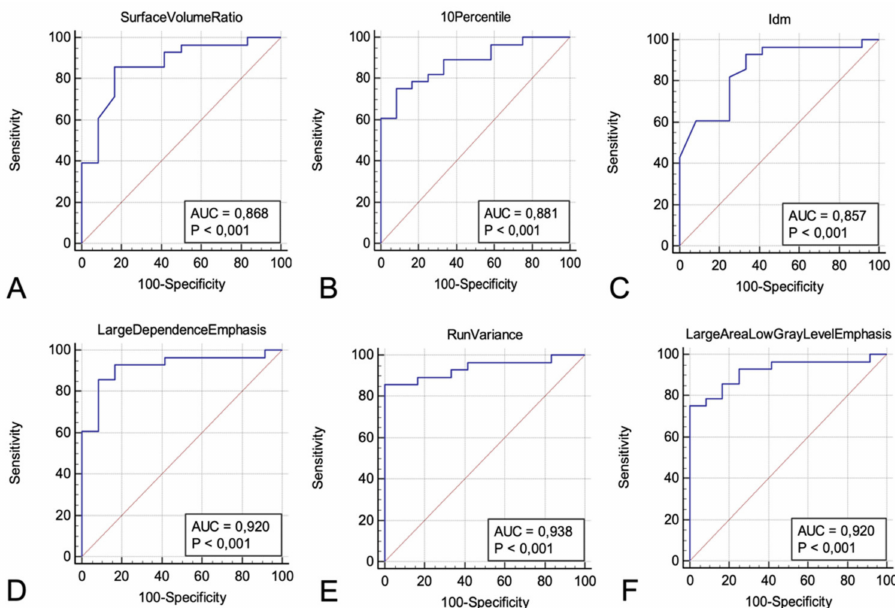
Figure 6. Receiver operating characteristic (ROC) curves used to test the performance of Radiomic features to discriminate lung cancer from tuberculosis, showing the best area under the curves (AUCs) for each category: ( A ) Surface Volume Ratio (AUC: 0.868, sensitivity: 85.7%, specificity: 83.3%, p < 0.0001) for Shape features; ( B ) 10Percentile (AUC: 0.881, sensitivity: 75%, specificity: 91.7%, p < 0.0001) for First Order features; ( C ) Idm (AUC: 0.857, sensitivity: 92.9%, specificity: 66.7%, p < 0.0001) in Grey Level Co-occurrence Matrix (GLCM) features; ( D ) Large Dependence Emphasis (AUC: 0.92, sensitivity: 85.7%, specificity: 91.7%, p < 0.0001) in Gray Level Dependence Matrix (GLDM) features; ( E ) Run Variance (AUC: 0.938, sensitivity: 85.7%, specificity: 100%, p < 0.0001) for Grey-Level Run Length Matrix (GLRLM) features; ( F ) Large Area Low Gray Level Emphasis (AUC: 0.92, sensitivity: 75%, specificity: 100%, p < 0.0001) for Gray Level Size Zone Matrix (GLSZM)